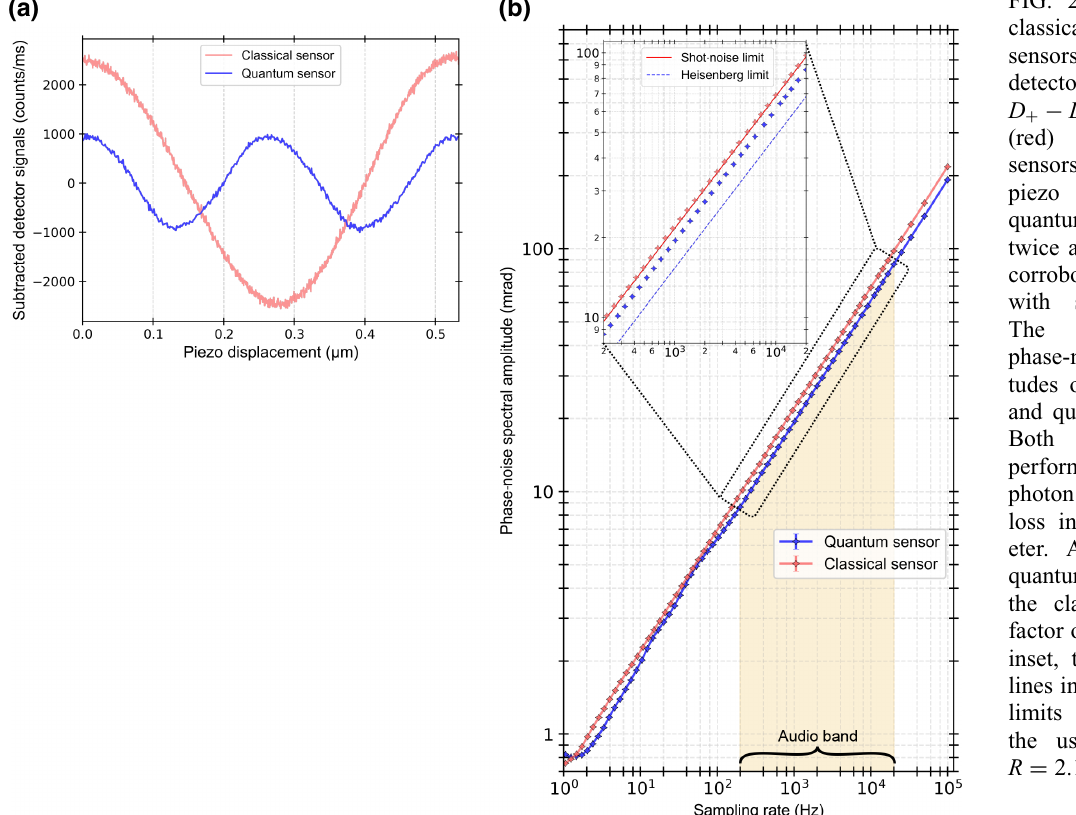
FIG. 2. Benchmarking the classical and quantum sensors. (a) The subtracted detector intensity signals D + − D − for the classical (red) and the quantum sensors (blue). For the same piezo displacement, the quantum sensor presents twice as many fringes, thus corroborating phase sensing with superresolution. (b) The frequency-dependent phase-noise spectral ampli- tudes of the classical (red) and quantum (blue) sensor. Both measurements are performed at identical photon fluxes, prior to any loss inside the interferom- eter. Above 200 Hz, the quantum sensor surpasses the classical sensor by a factor of 1.13 ± 0.02. In the inset, the solid and dotted lines indicate the theoretical limits of both sensors at the used photon rate of R = 2.14 × 10 6 s − 1